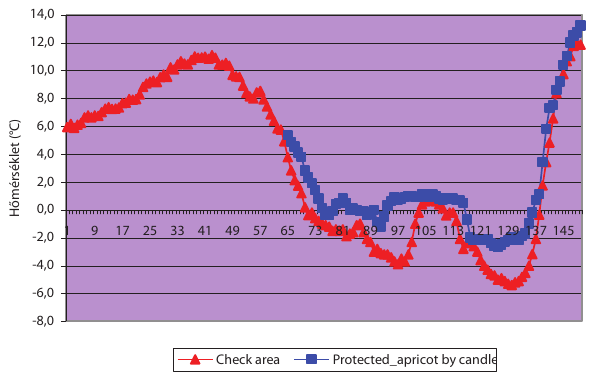
Figure 5 – The temperature regulated and protected by the use of the Frostbuster procedure compared with the check area during the late frost period between April 9. 09.00 and April